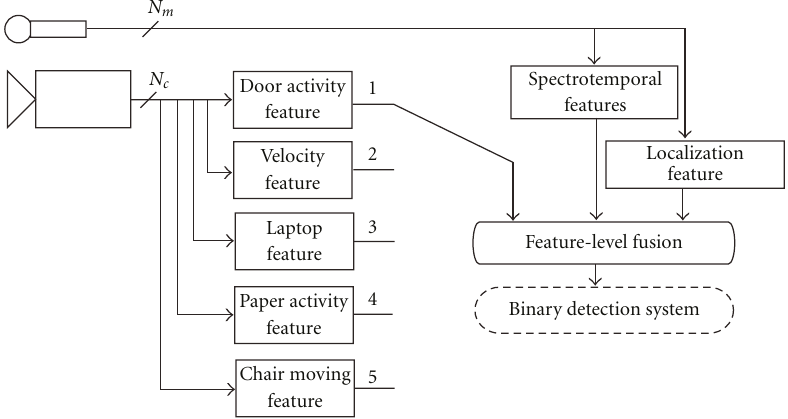
Figure 6: System